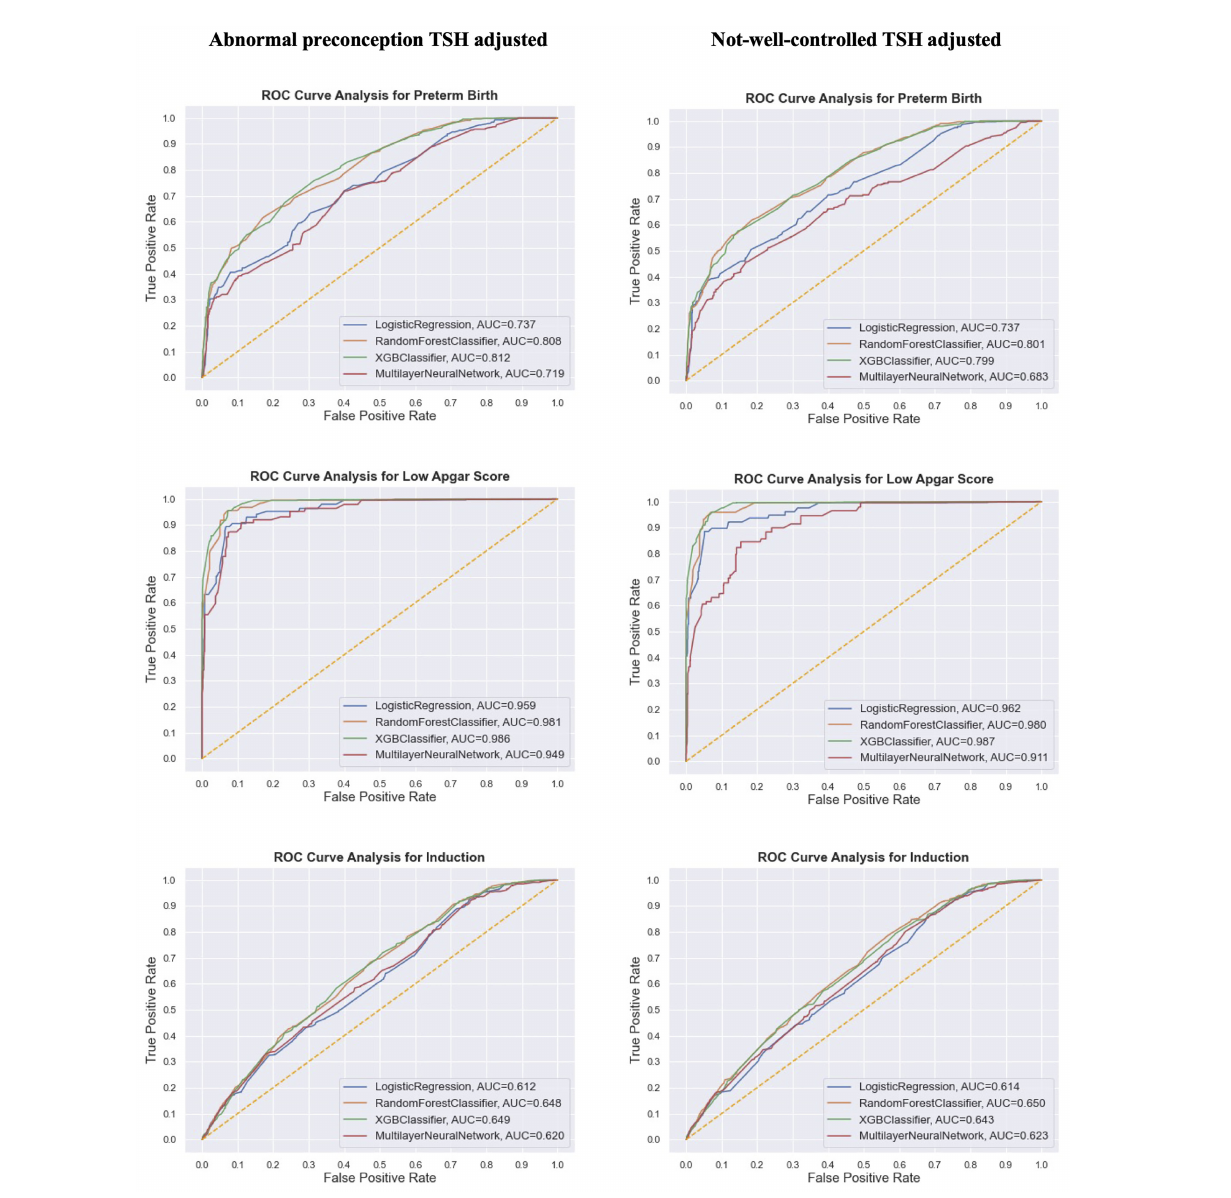
FIGURE 1 | Comparison of model performance (AUC/ROC curve) of the synthetic data on three dichotomous birth outcomes from the research subjects in the second analysis. Different TSH derivatives were adjusted in two separate predictive models with other predictive features staying the